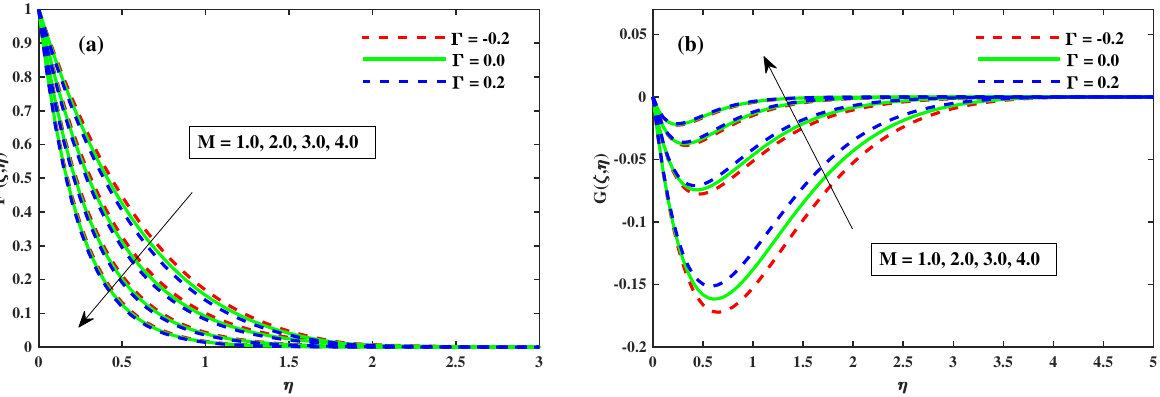
Figure 2. Influence of M on G along y-direction in ( b ), and F (cid:48) along x-direction in ( a ) when ζ = 1.